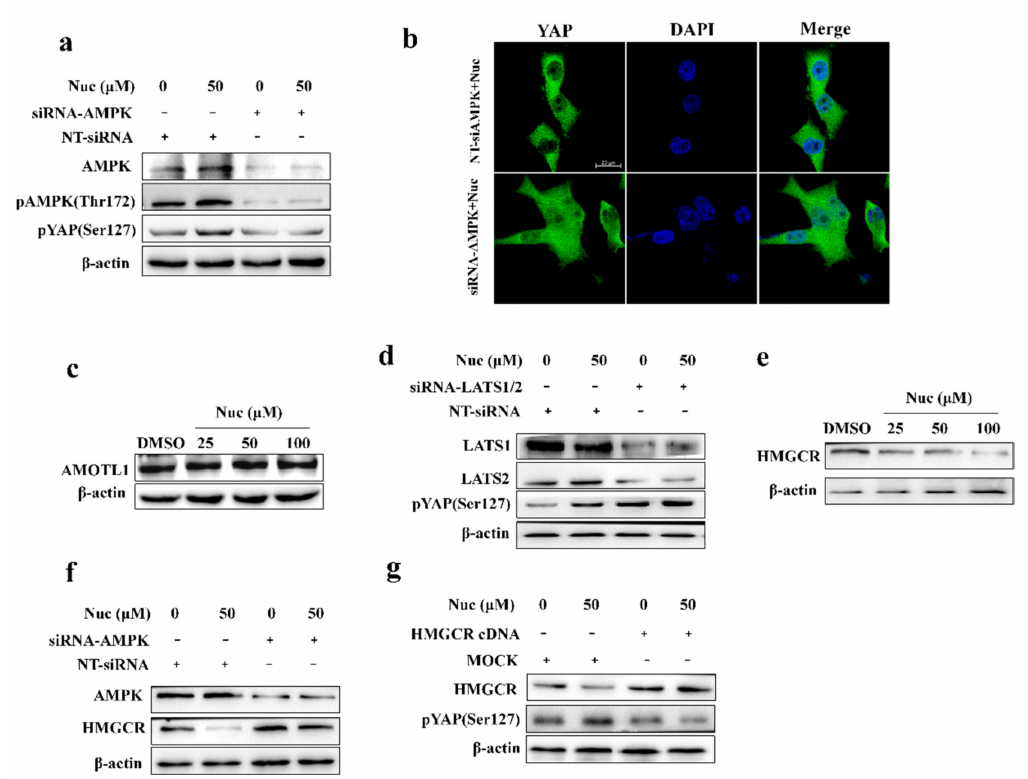
Figure 4. AMPK-mediated 3-hydroxy-3-methyl-glutaryl-coA (HMGCR) downregulation is needed for nuciferine to induce pYAP(Ser127). ( a ) Western blot of AMPK, pAMPK(Thr172), pYAP(Ser127) and β -actin from PANC-1 cells transfected with none-targeted siRNA(NT-siRNA) and siRNA-AMPK. ( b ) YAP nuclear translocation in PANC-1 cells transfected with NT-siRNA and siRNA-AMPK in the presence of nuciferine (50 µ M). Scale bars: 20 µ m. ( c ) Western blot of AMOTL1 and β -actin (a loading control); ( d ) Western blot of LATS1, LATS2, pYAP(Ser127) and β -actin from PANC-1 cells transfected with NT-siRNA and siRNA-LATS1 / 2. ( e ) Cells were treated with nuciferine or DMSO for 72 h and collected for WB. ( f ) Western blot of AMPK and HMGCR from cells transfected with NT-siRNA and siRNA-AMPK. ( g ) Cells transfected with HMGCR overexpressed plasmid were treated with nuciferine or DMSO for 72 h and collected for western blot. Nuc, nuciferine; Gem,